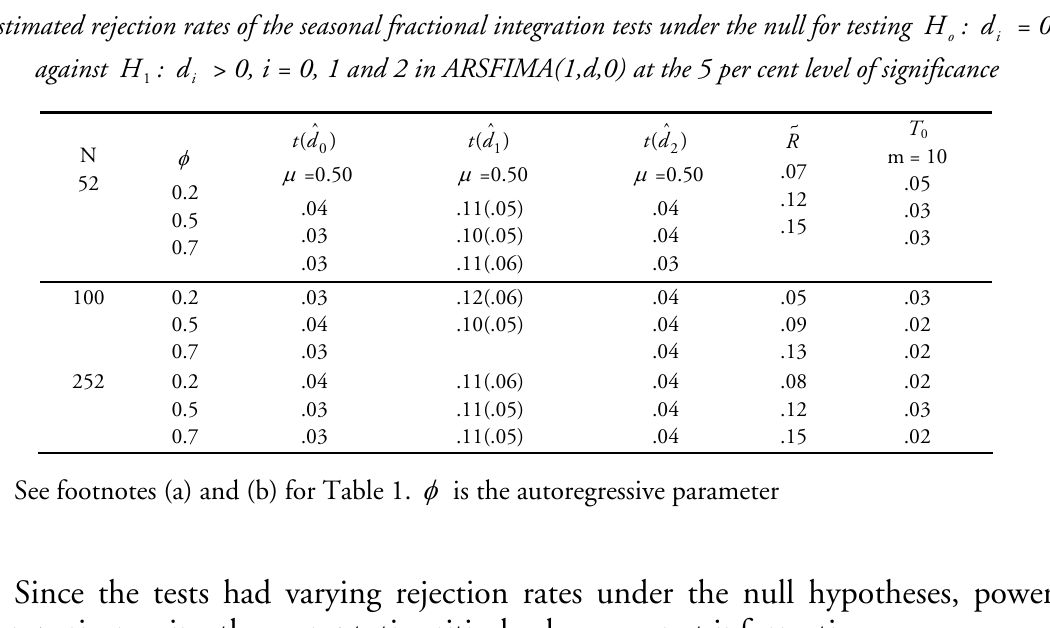
Estimated rejection rates of the seasonal fractional integration tests under the null for testing